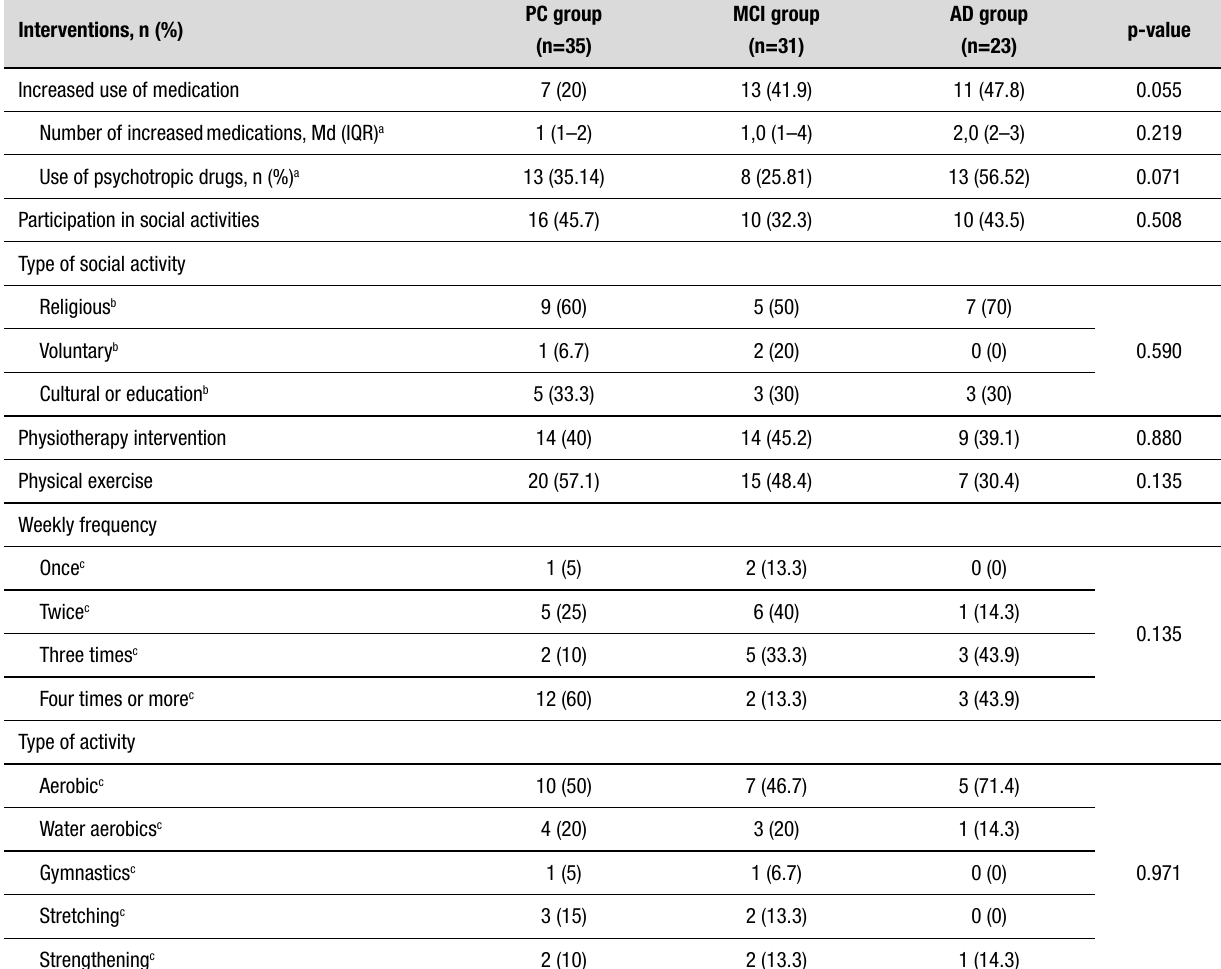
Table 2. Interventions performed during